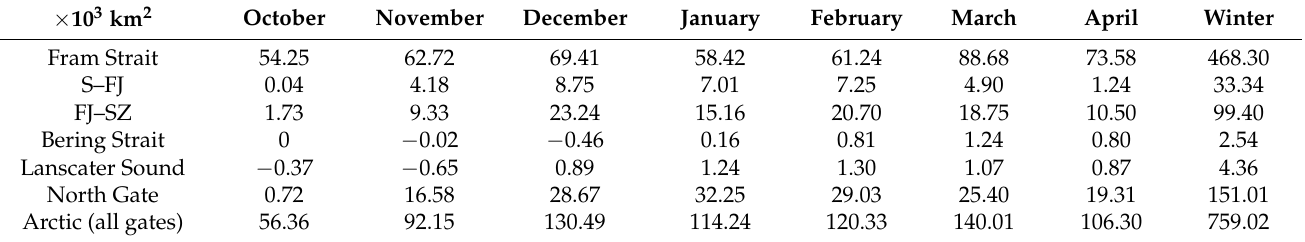
Table A1. Winter and monthly total sea ice flux.